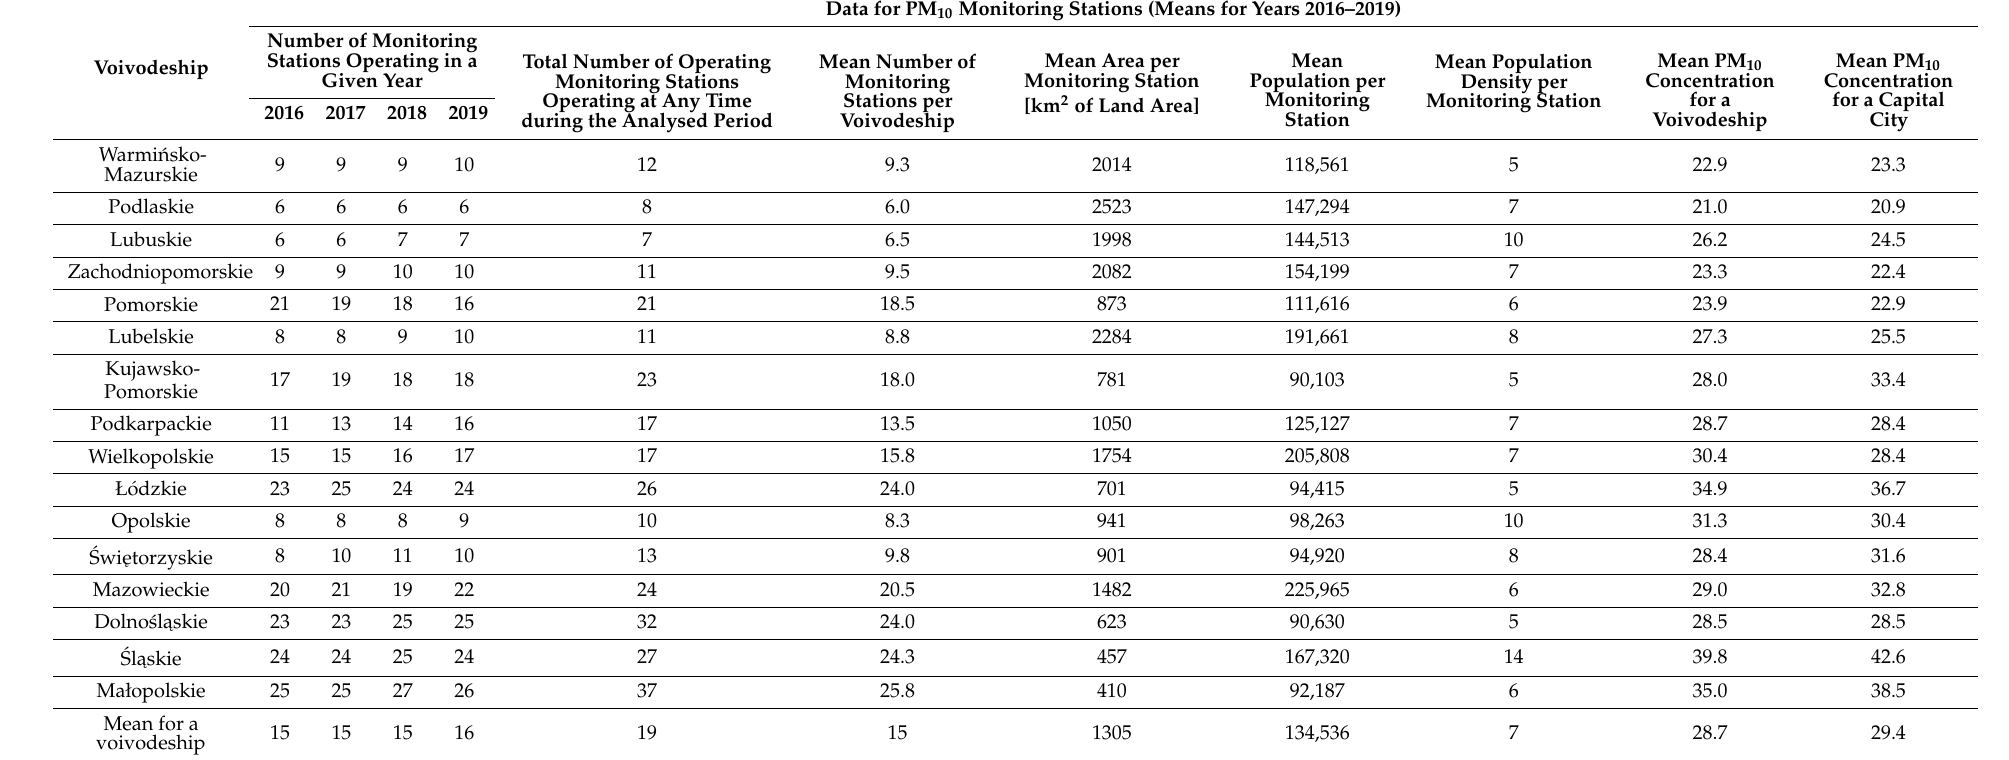
Table 2. General characteristics of PM 10 monitoring stations operating between years 2016–2019 in